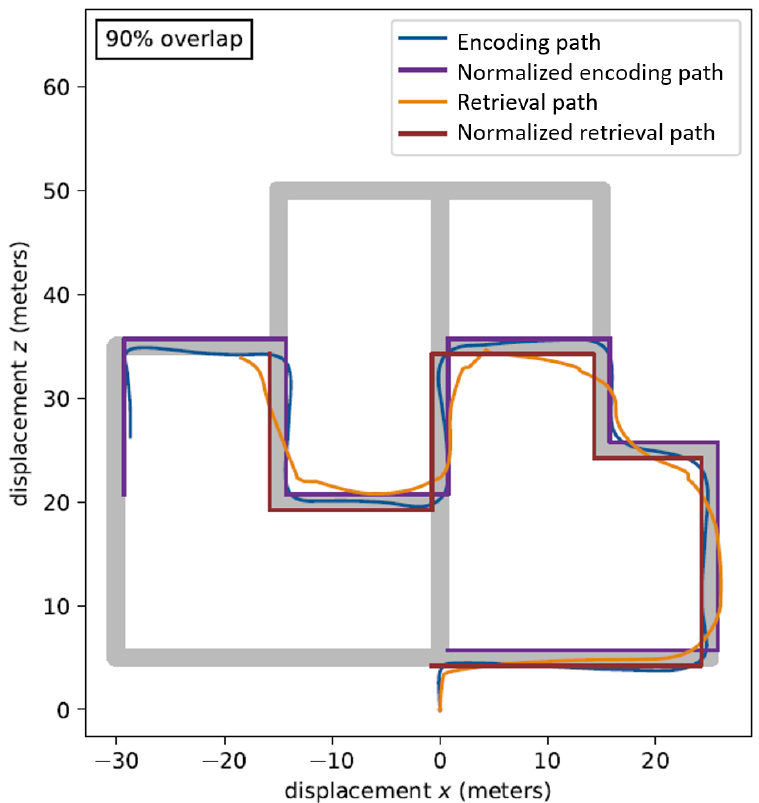
Figure 2. Example of the paths travelled in one of the virtual environments at encoding and retrieval before and after normalization.